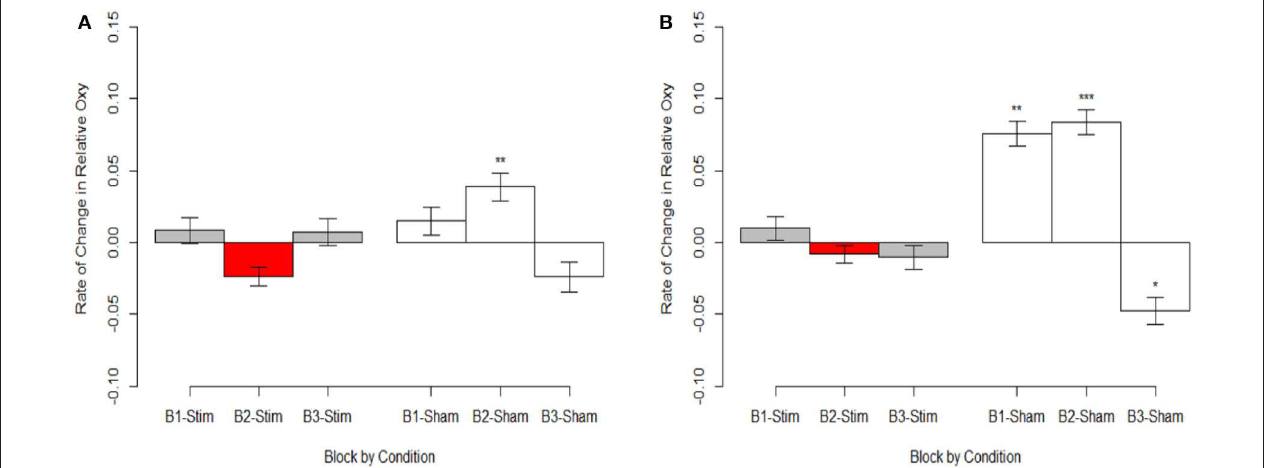
FIGURE 7 | Magnitude of oxygenation change during hemodynamic response. (A) Optode 1 left dorsolateral BA 44/45. (B) Optode 15 right dorsolateral BA 44/45. Red bar represents comparison condition for dummy coding in mixed effects regression models. * p < 0.05, ** p < 0.01, *** p <